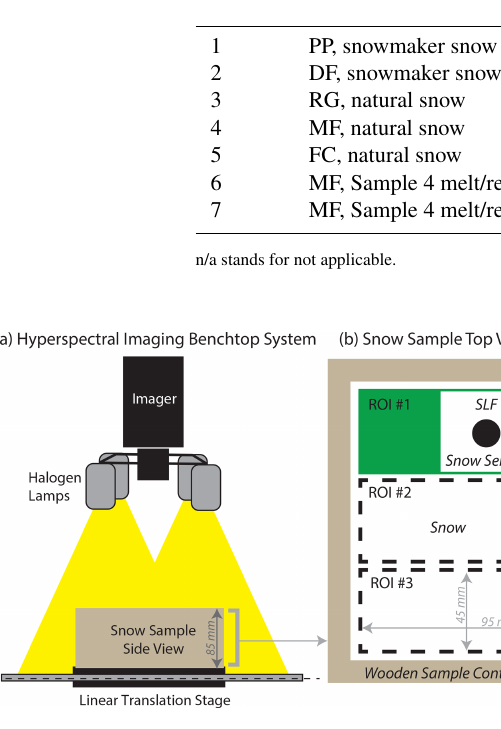
Figure 4. Schematic of laboratory setup. (a) Front view of the Resonon hyperspectral imaging benchtop system and wooden snow sample container. (b) Top view of the snow sample container show- ing the three regions of interest (ROIs) measured by the SLF Snow Sensor, which is shown inside of ROI no.